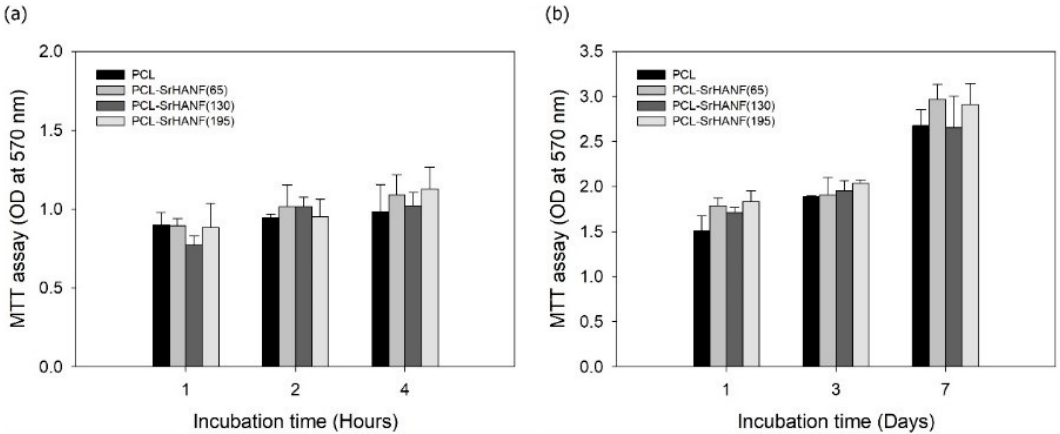
Figure 6. 3-(4,5-dimethylthiazol-2-yl)-2,5-diphenyltetrazolium bromide (MTT) assay quantifying cell attachment and proliferation on PCL–SrHANF membranes. ( a ) Attached MG63 osteoblast-like cells on various membranes after culturing for up to 4 h. ( b ) Viability of MG63 osteoblast-like cells on various membranes after culturing for up to 7 days. The data are presented as the mean ± SD, n = 3.